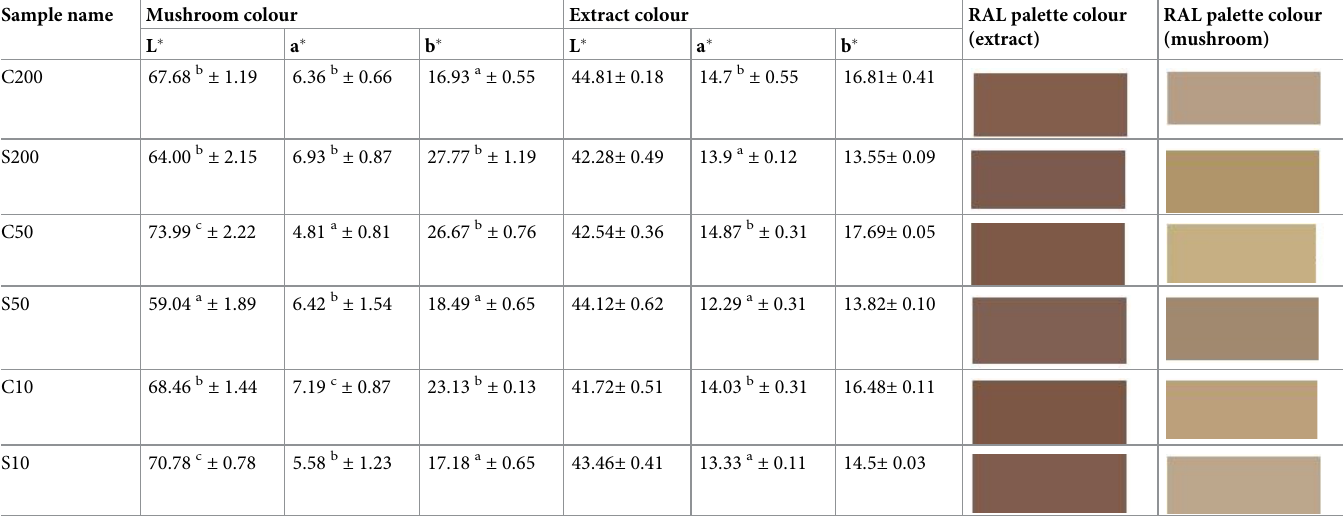
Table 1. Characteristics of the studied anatomical parts of the oyster mushroom (Pleurotus ostreatus L. ) and their extracts expressed in units of L � a � b � .